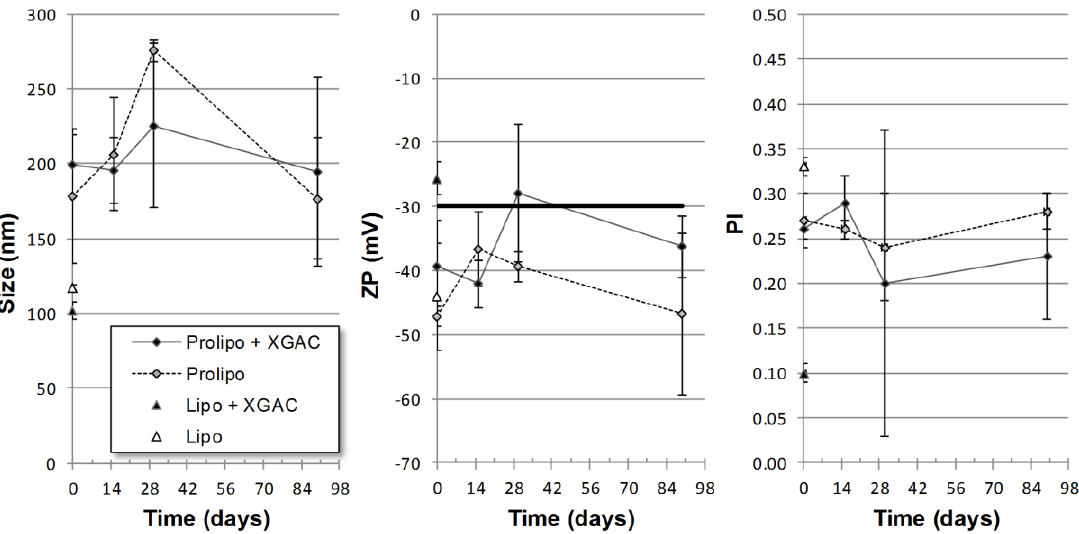
Figure 4. Effective diameter, PI and ZP of liposomes and proliposomes with and without xanthone 2 (XGAC), from the day of production, 15, 30, and 90 days